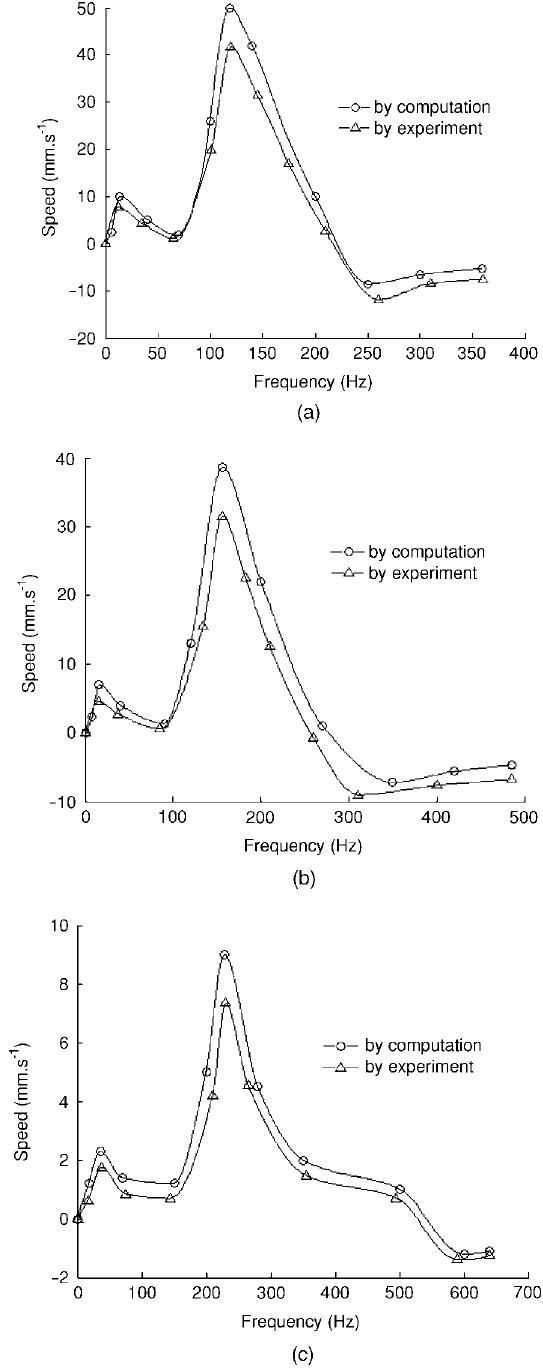
Figure 15 Simulation and experiments on swimming speeds of robot fish with different shape of caudal fin: (a) b 1 ( x ) = 4.0 × 10 6 x 7 + 0.002; (b) b 2 ( x ) = 7.2 × 10 5 x 6 + 0.002; and (c) b 3 ( x ) = 0.004. For all the three fish robots with three types of fin shape, the magnetic field excitation current is set at 0.25A, and the driving frequency is changed from 0 to 650 Hz. The mean swimming speed of each fish robot is measured by the ultrasonic sensor system, and the results are plotted in Figure